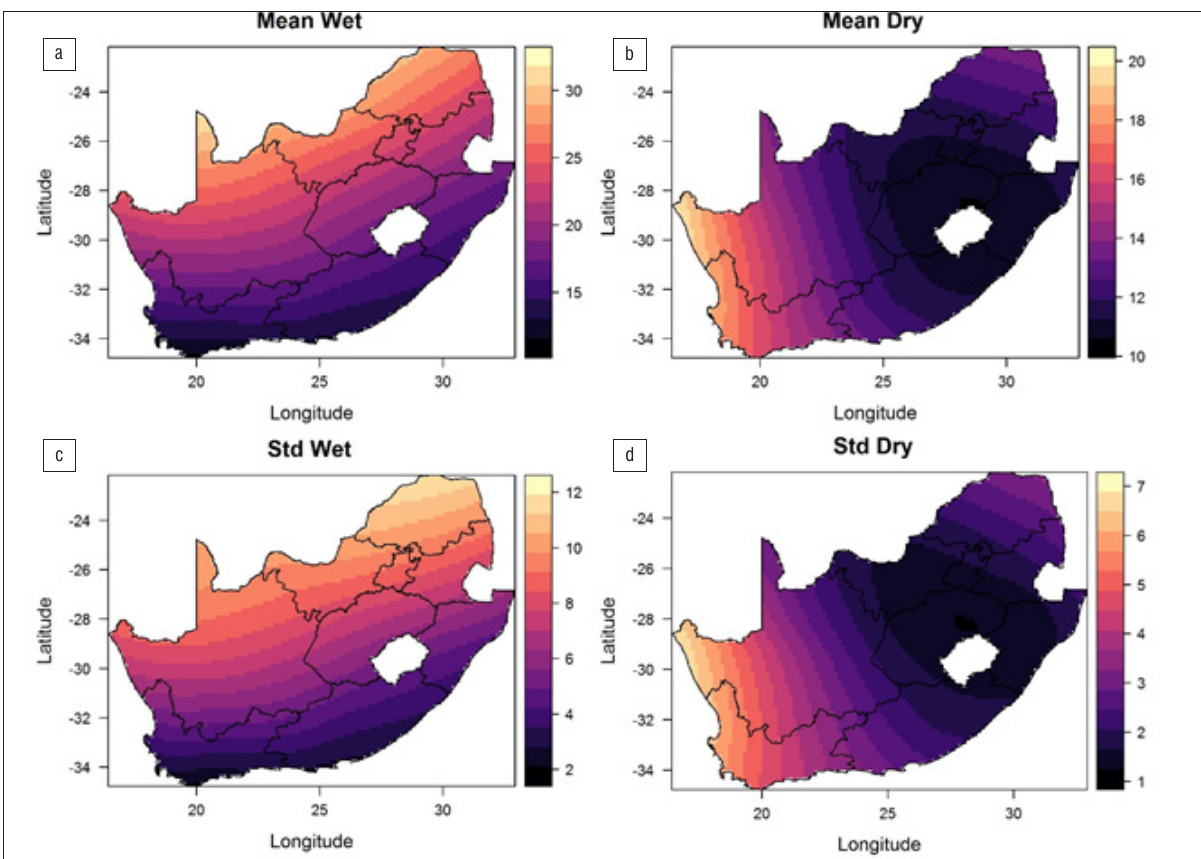
Figure 7 : Spatial variability of supra-seasonal precipitation concentration index for (a,c) wet and (b,d) dry supra-seasons.